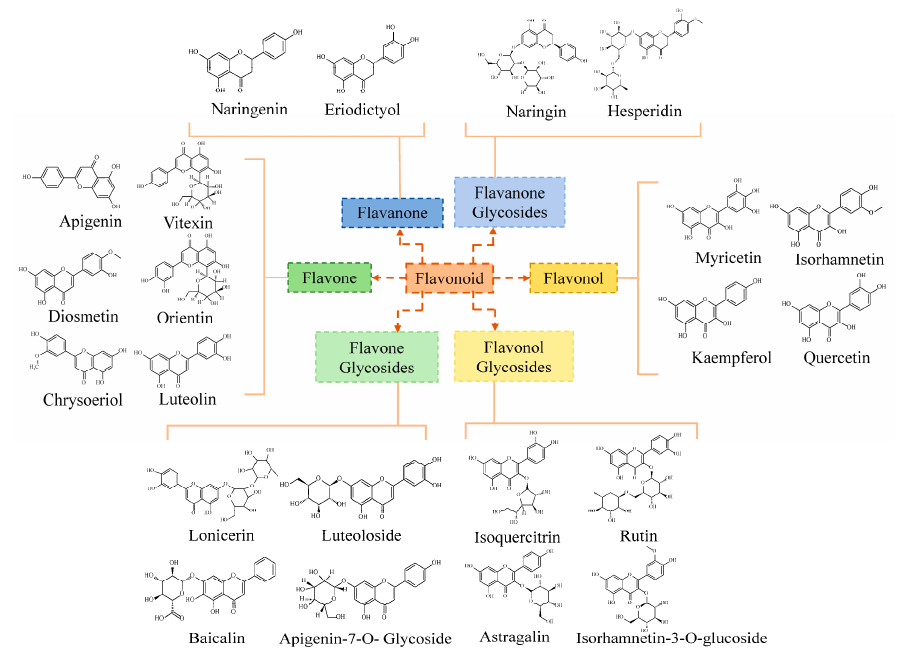
Figure 5. Classification map of flavonoids.